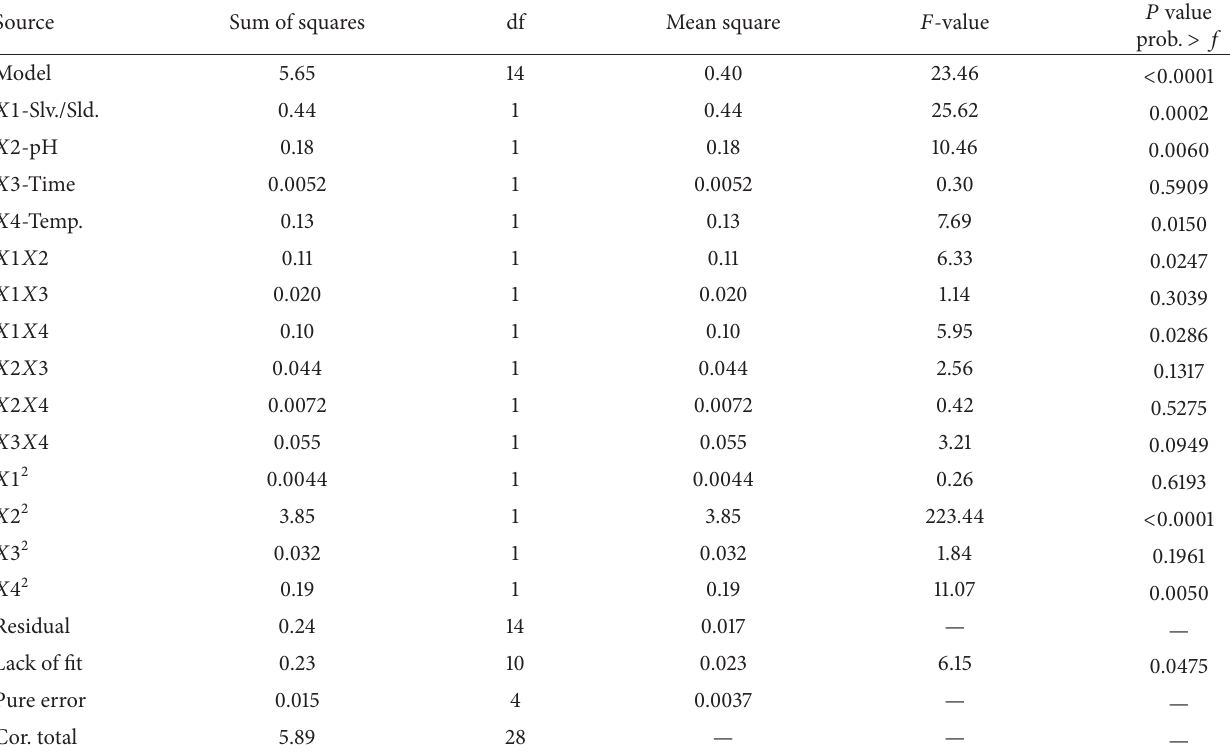
Table 4: The analysis of variance (ANOVA) for the quadratic equations of design expert 8.0.7.1 for the EY.